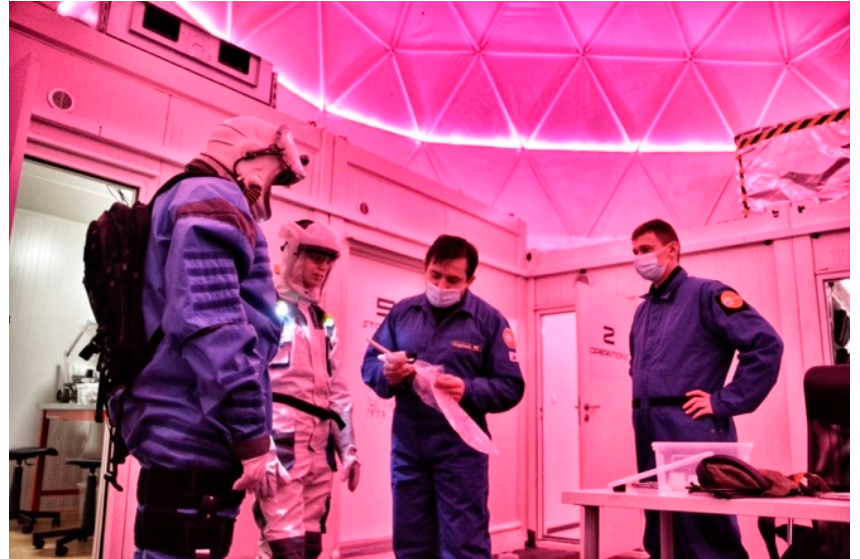
Figure 2. Analog astronauts during one of the analog space missions of Pandemic Isolation Cam- paign (2021) .